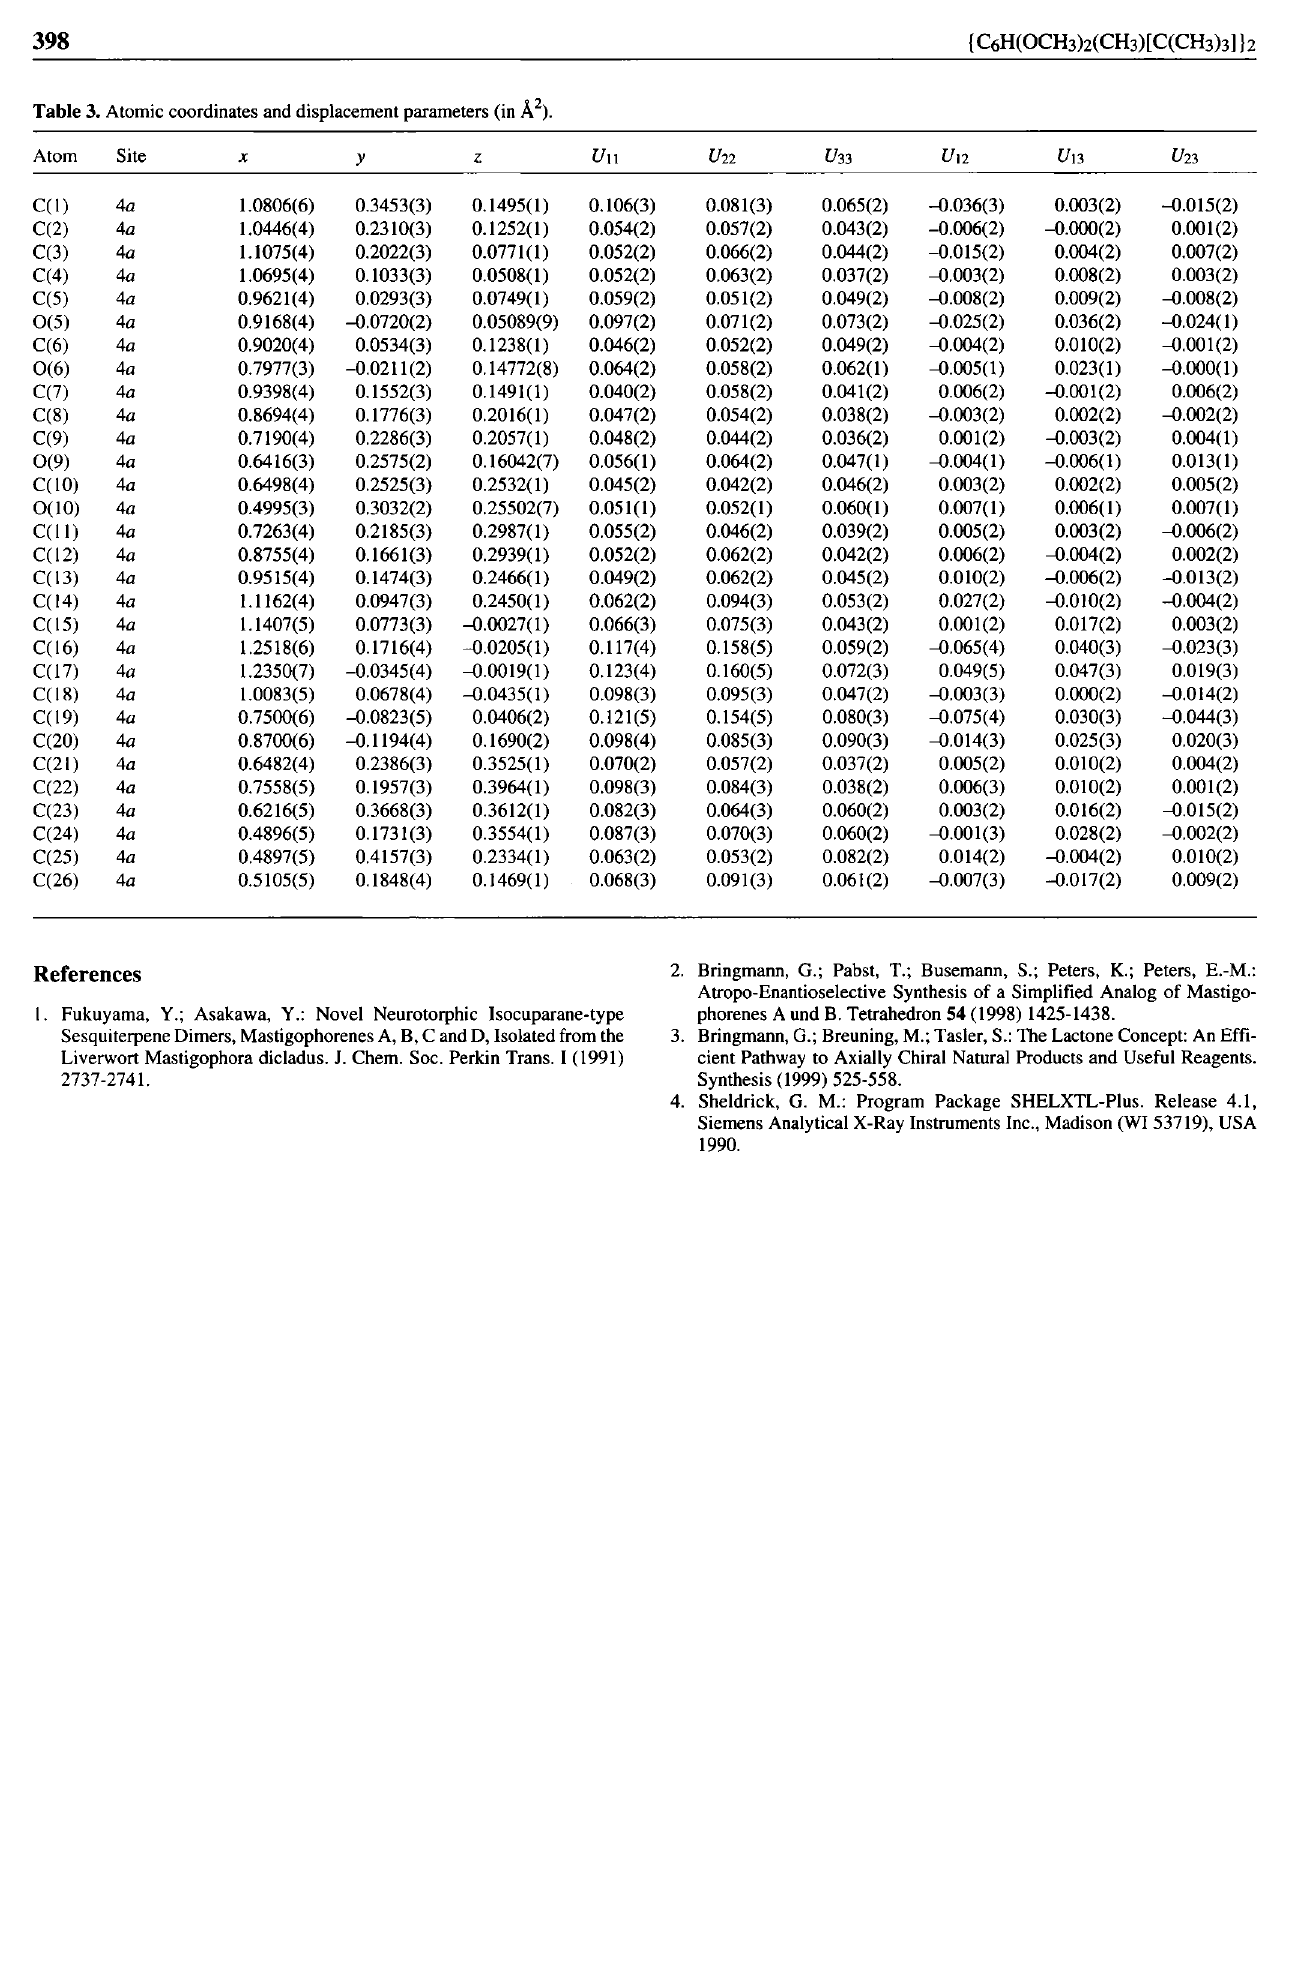
Table 3. Atomic coordinates and displacement parameters (in Ä 2